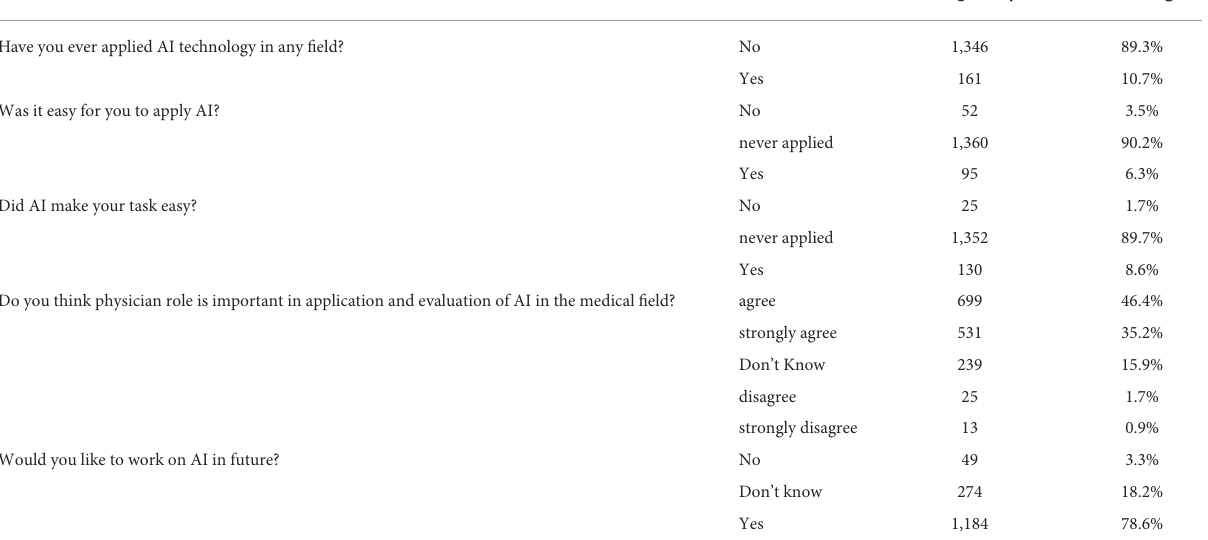
TABLE 9 Descriptive statistics for practice of artificial